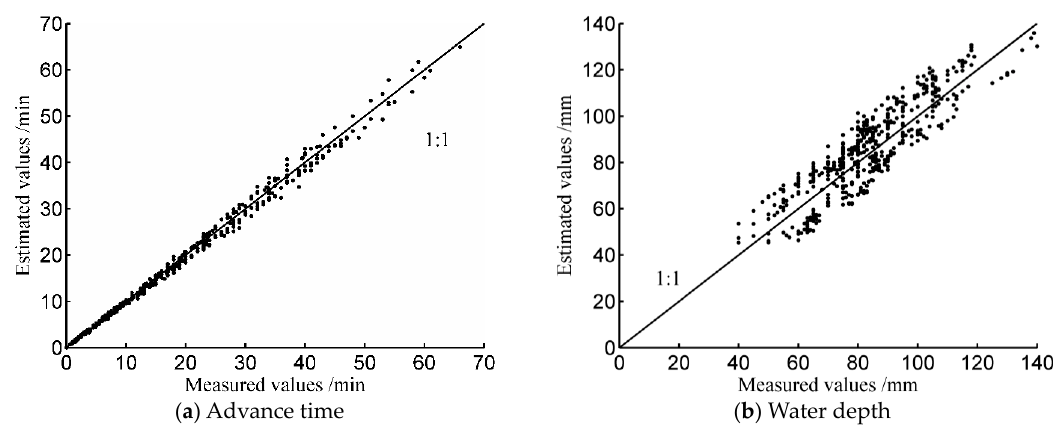
Figure 2. Comparisons of measured and simulated advance time and water depth in the upstream using WinSRFR.